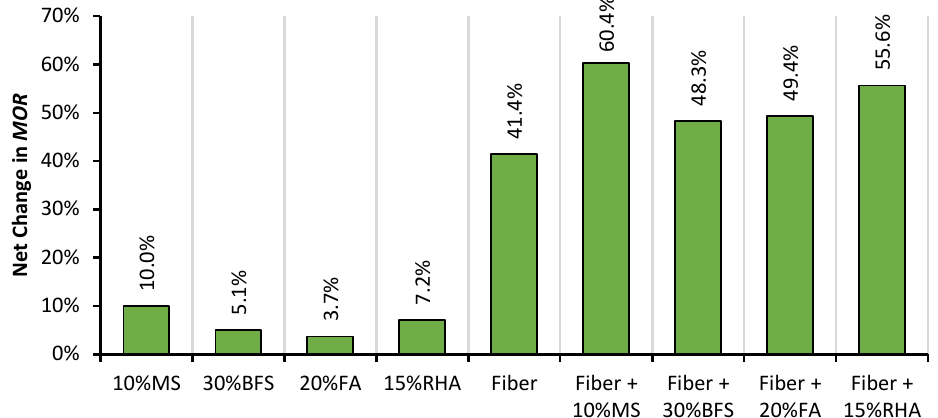
Figure 14. The effect of mineral admixtures and glass fibers on the modulus of rupture (MOR) of RAC.